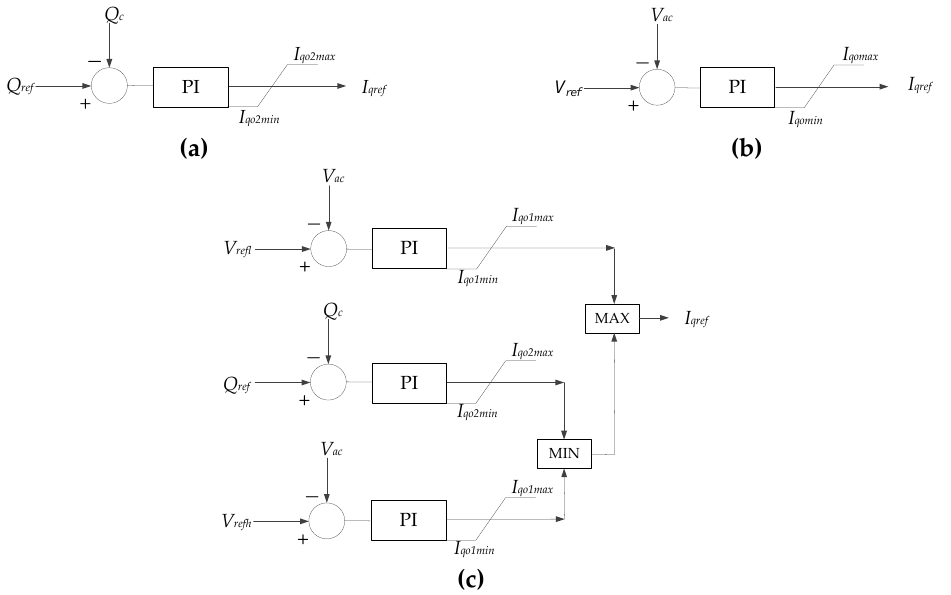
Figure 1. Three reactive power controllers for voltage source converter high-voltage direct current (VSC-HVDC) link. ( a ) Constant reactive power control; ( b ) constant AC voltage control; ( c ) AC voltage margin control.